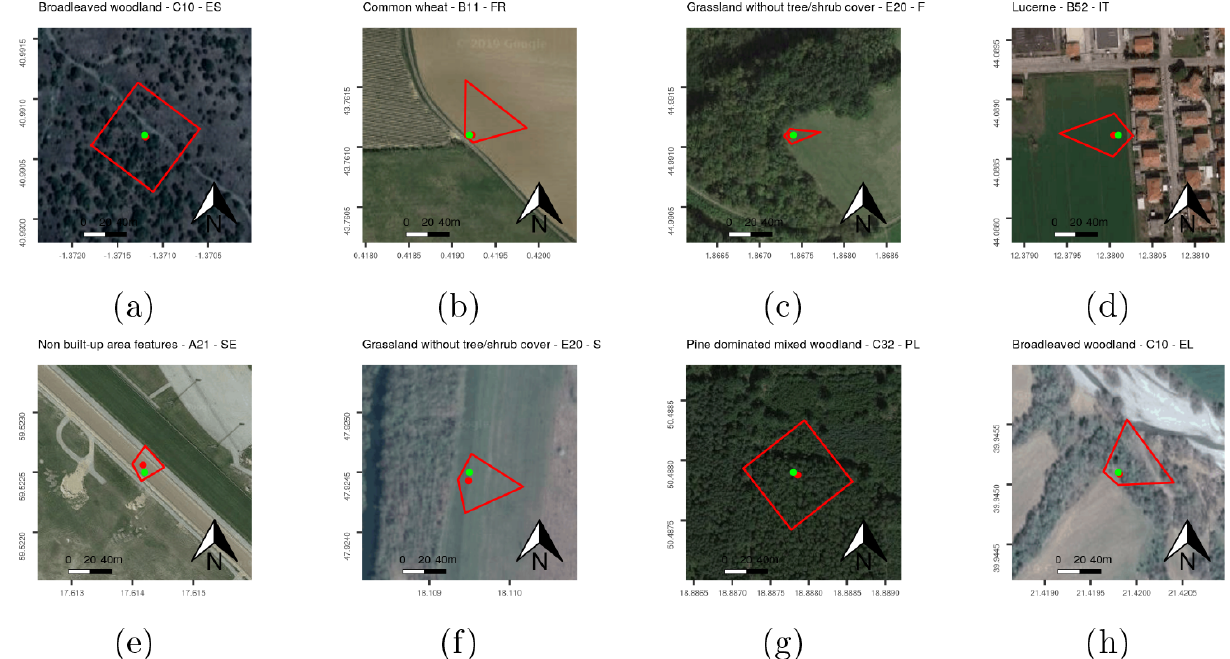
Figure 4. Examples of LUCAS Copernicus built polygons. The green point is the theoretical LUCAS point. The red point is the GPS location of the Copernicus surveyor. Polygons are built using distances in the N, E, S, and W directions collected on the ground. The background RGB imagery is obtained from map data ©2019